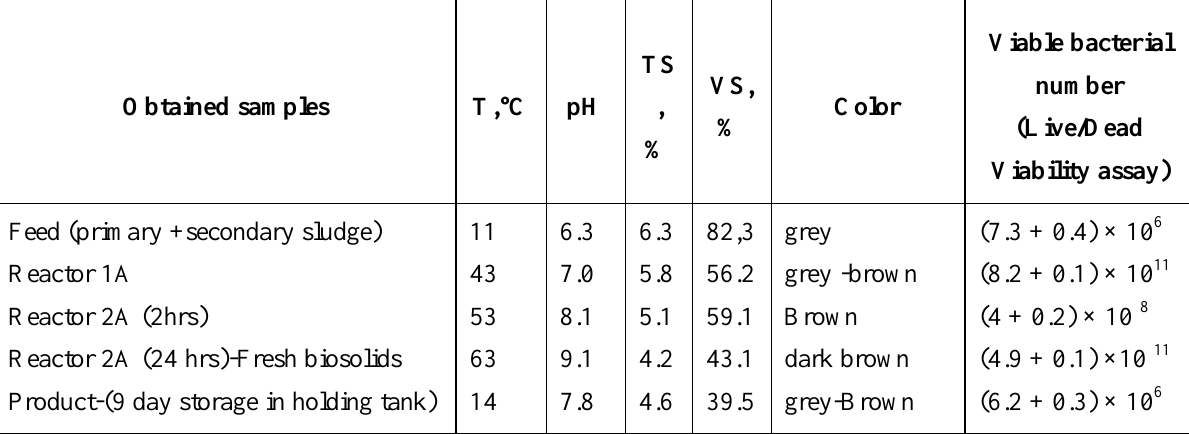
Table 3. Characteristics of the sludge samples obtained at different stages of ATAD